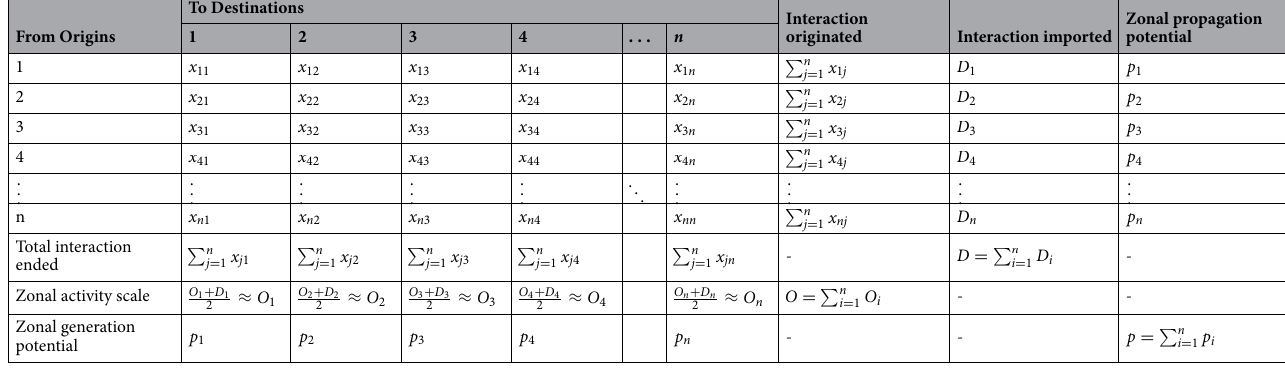
Table 1. Interaction transmission